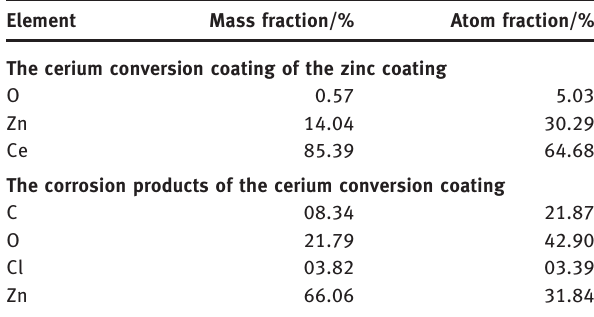
Table 3: The composition